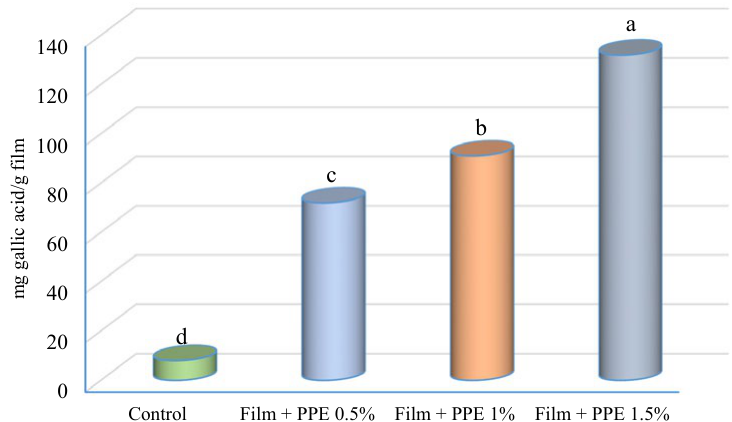
Fig. 4. Total phenolic contents of chitosan-ZnO films containing different concentrations of pomegranate peel extract (PPE; 0.5, 1 and 1.5%). Values are expressed as mean ± standard deviation. Different letters indicate significant differences (P < 0.05)